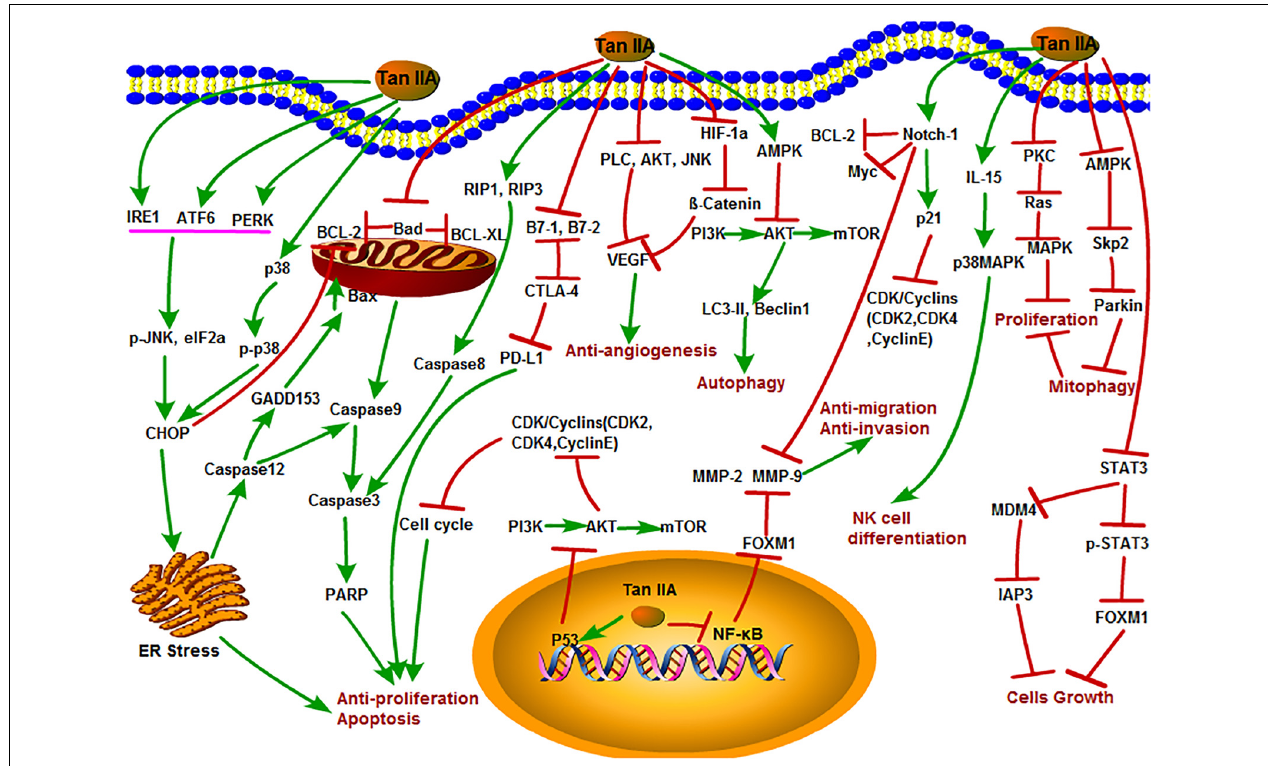
FIGURE 2 | The antitumor mechanism of Tan IIA. Tanshinone IIA inhibits cancer cell proliferation, induces differentiation and apoptosis through MAPK, AMPK/Skp2/Parkin, ER stress and mitochondrial pathway, inhibits of invasion and migration through Notch1/NF- κ B signaling, induces of autophagy in cancer cells through PI3K/Akt/mTOR signaling pathway, and inhibits angiogenesis by inhibiting the activity of VEGF. The arrow represents the promotion effect, and the T area represents the inhibition